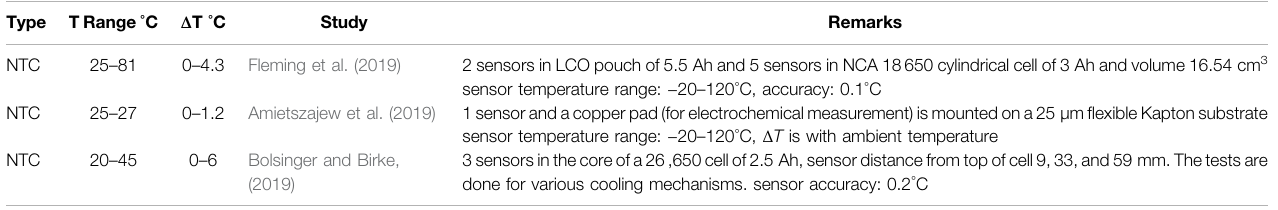
TABLE 2 | Details on thermistors used in LIBs.